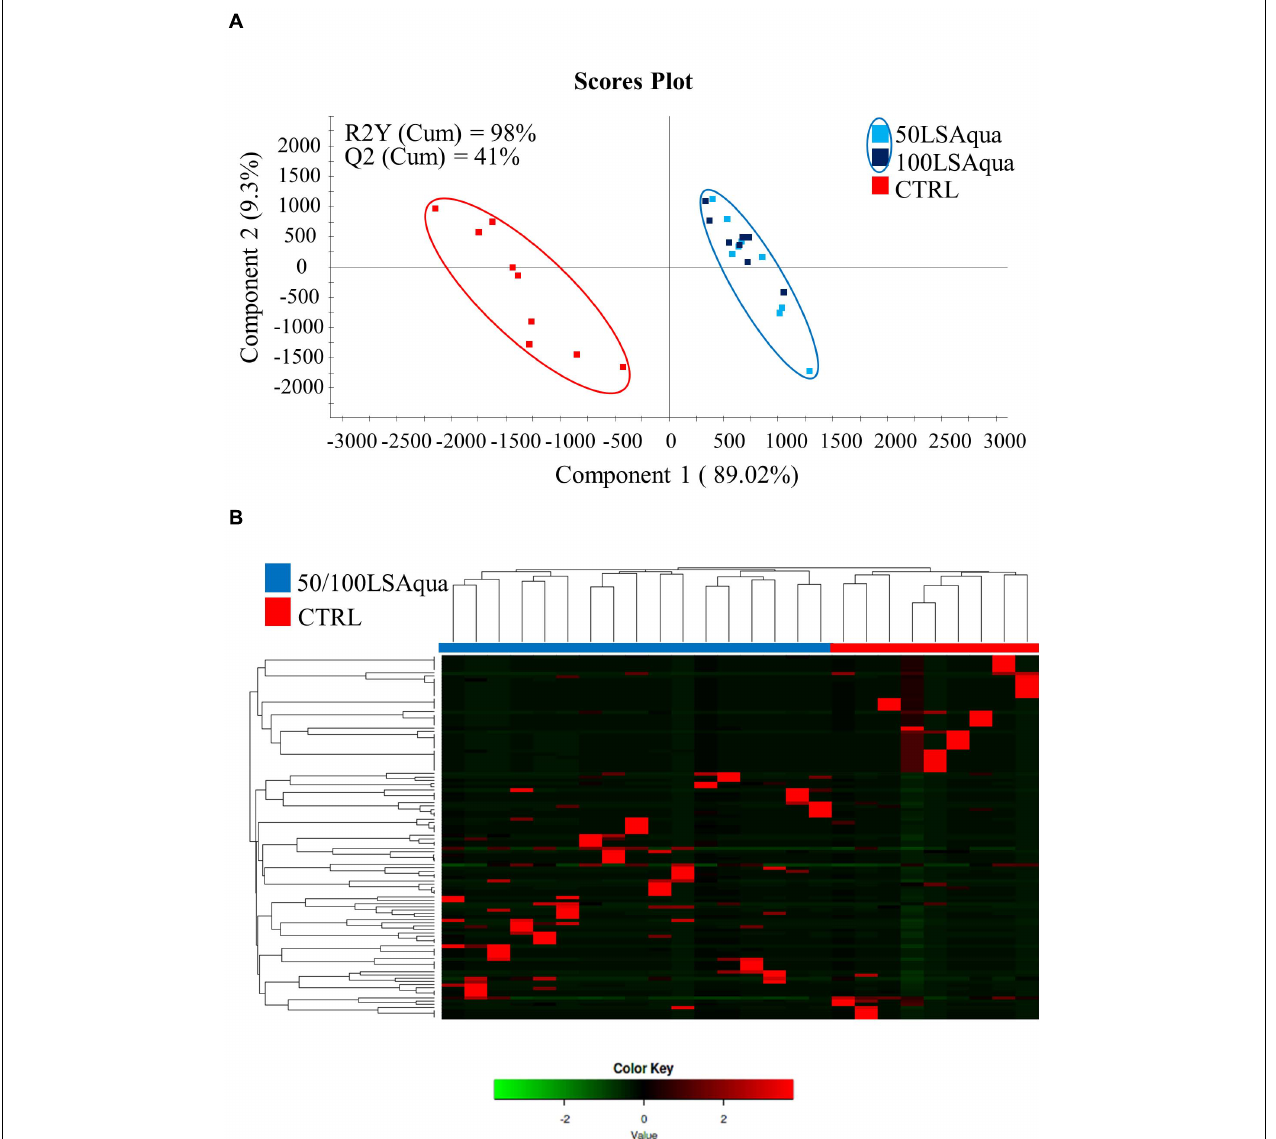
FIGURE 5 | (A) Two-dimensional PLS-DA scores plot constructed using the variable diet with all groups, representing the distribution of the samples between the first two components in the model. The validation by the permutation test can be found in Supplementary Figure 2 . (B) Heatmap representing the abundance distribution ( Z -score) of the OTUs identified to be driving the separation by diet among all groups.